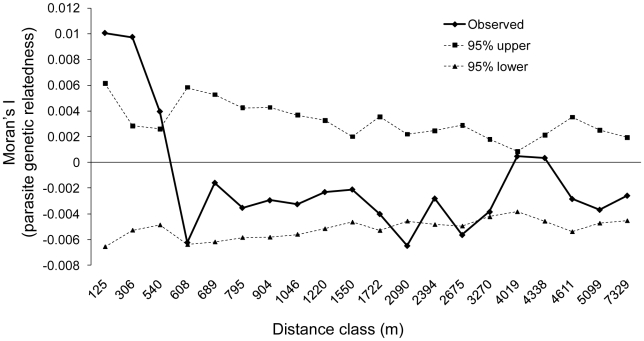
Spatial autocorrelation analysis showing nearby houses share genetically related parasites.Distance classes up to 540 m show higher parasite genetic similarity compared to values generated from random allocation of households among geographic locations (95% upper and lower confidence values). This result was also found when a single parasite was sampled from each household (Fig. S5), demonstrating that this result is not driven by a small number of heavily infected households.